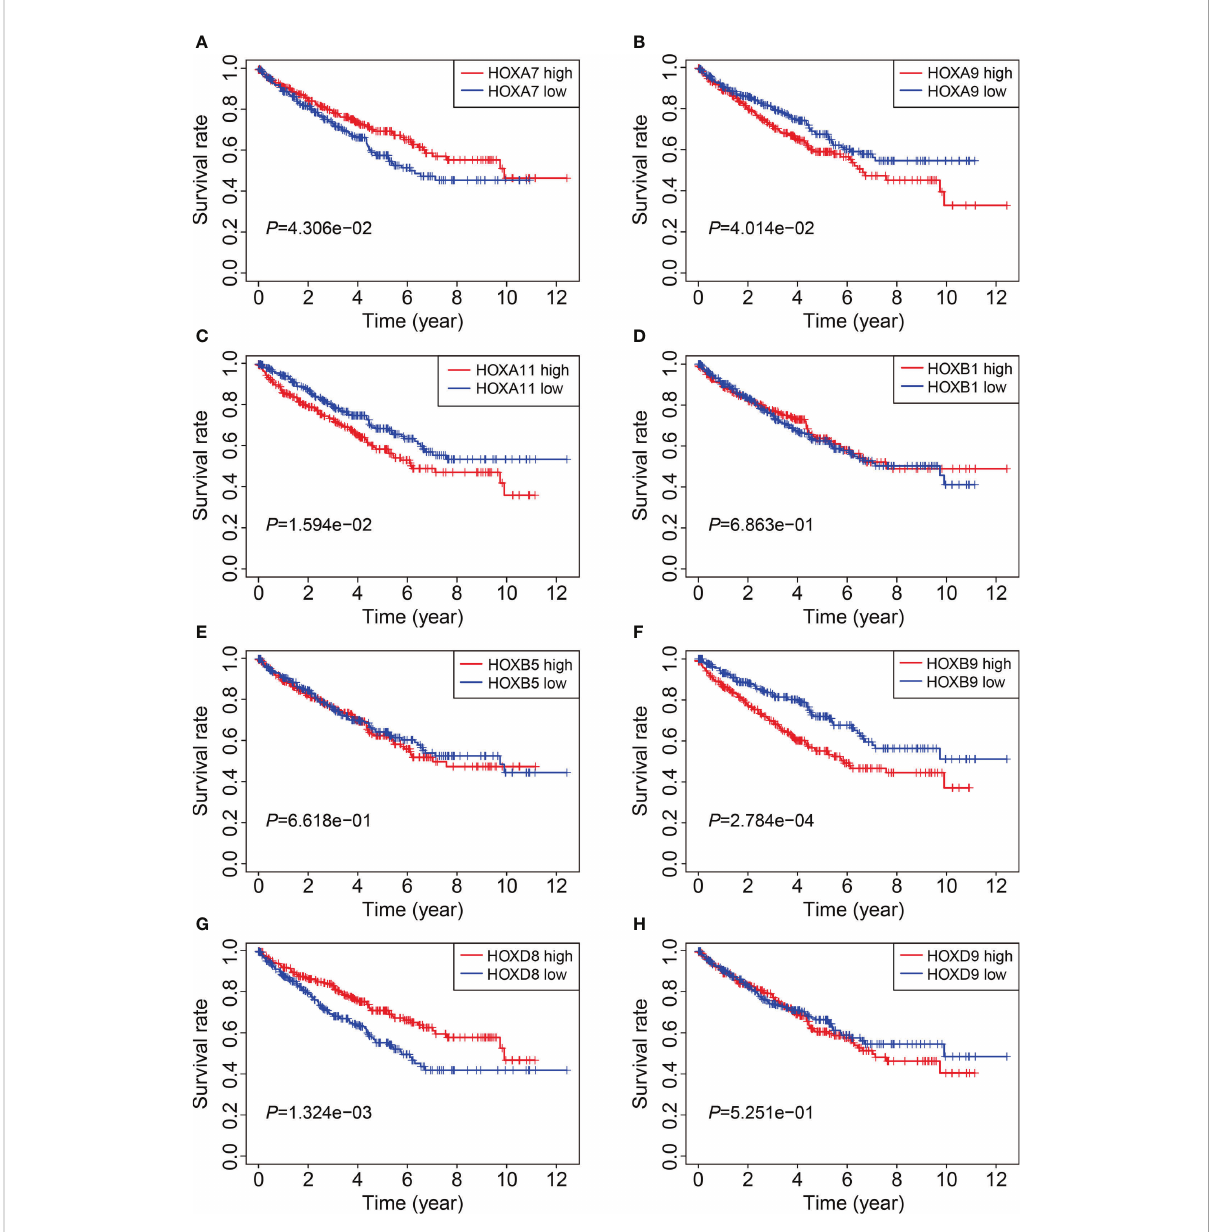
FIGURE 11 Kaplan-Meier survival analysis of HOXA7 (A) , HOXA9 (B) , HOXA11 (C) , HOXB1 (D) , HOXB5 (E) , HOXB9 (F) , HOXD8 (G) , and HOXD9 (H) in TCGA